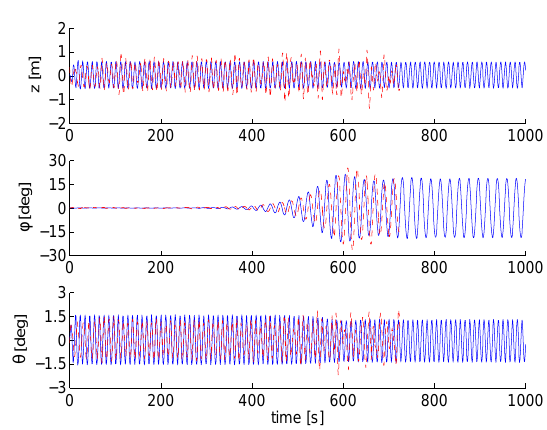
Figure 4: Exp. 1174. Exp. dashed red, sim. solid blue.